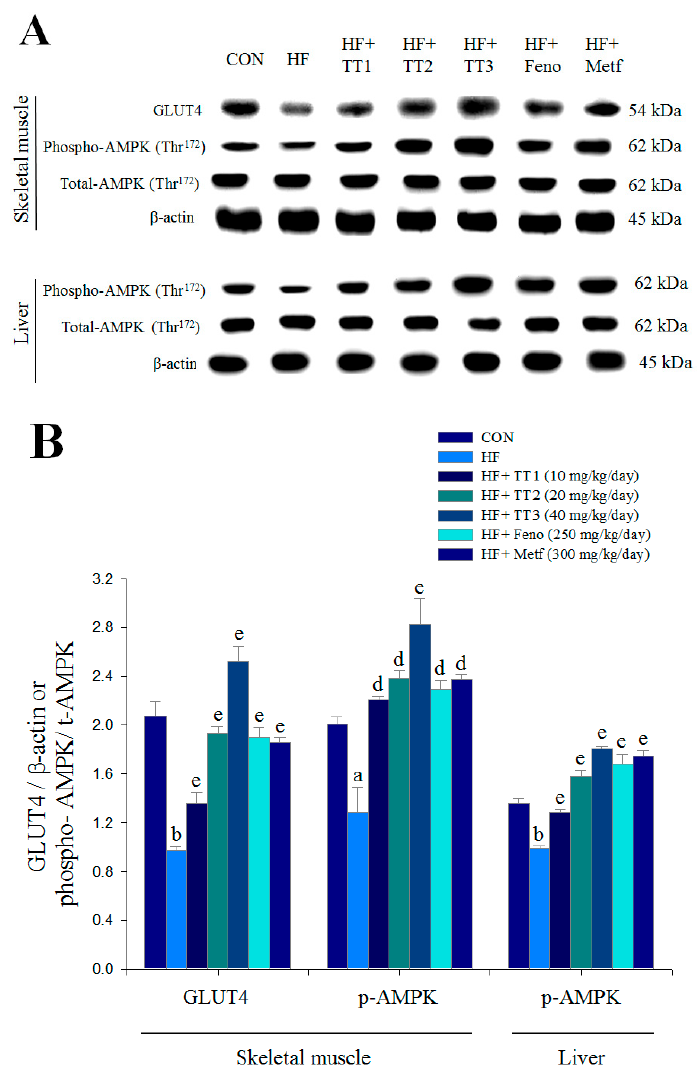
Figure 5. The skeletal muscular expression levels of membrane GLUT4 and phospho-AMP-activated protein kinase (AMPK) (Thr 172 ), and hepatic expression levels of phospho-AMPK (Thr 172 ) from the high-fat diet (HFD)-fed mice by oral gavage dehydroeburicoic acid (TT): ( A ) representative image; ( B ) quantification of the GLUT4 expression levels and the ratio of phospho-AMPK to total AMPK (mean ± SE, n = 9). Protein was separated by 12% SDS-PAGE detected by Western blot. a p < 0.05 and b p < 0.01 compared with the control (CON) group; d p < 0.01, and e p < 0.001 compared with the high-fat-diet plus vehicle (distilled water) (HF) group. TT, dehydroeburicoic acid (TT1, TT2, and TT3, 10, 20, and 40 mg/kg body weight, respectively); fenofibrate (Feno, 250 mg/kg body weight), or metformin (Metf, 300 mg/kg body weight).